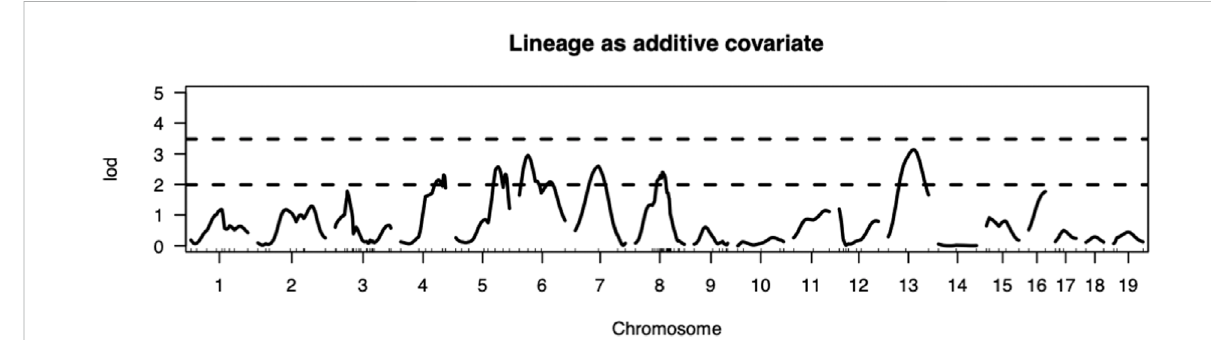
FIGURE 1 Genome-wideanalysisrevealedQTLsonChromosomes4,5,6,7,8,and13.ThresholdsforLODscoresarebasedon1,000permutationtests.In thisintercross thevalues ofLODscorethresholdsare 2.23and3.27for suggestive ( p < 0.63)andsigni fi cant ( p < 0.05)levels, respectively, whensexis included as an additive covariate and mitochondrial lineage added as additive